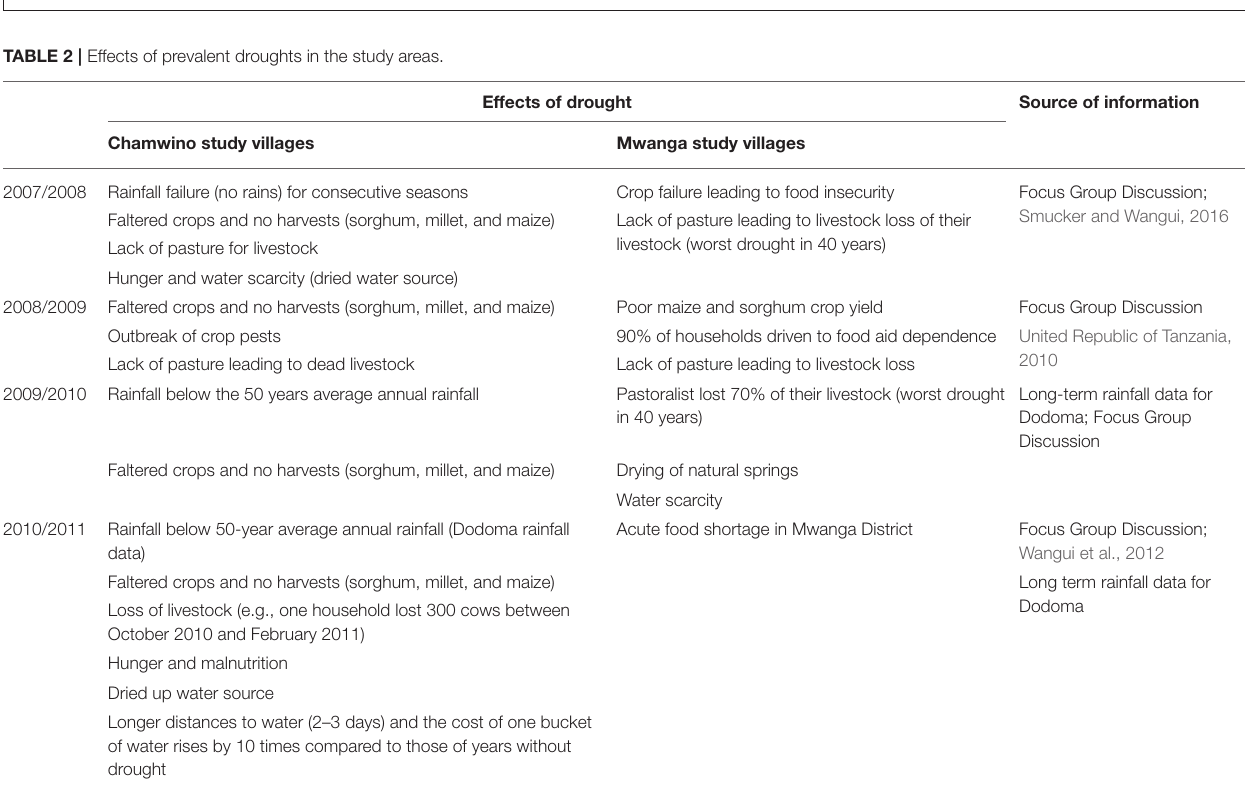
FIGURE 2 | Long-term (1961 − 2011) annual rainfall for Dodoma (data source: Tanzania Meteorological Agency).